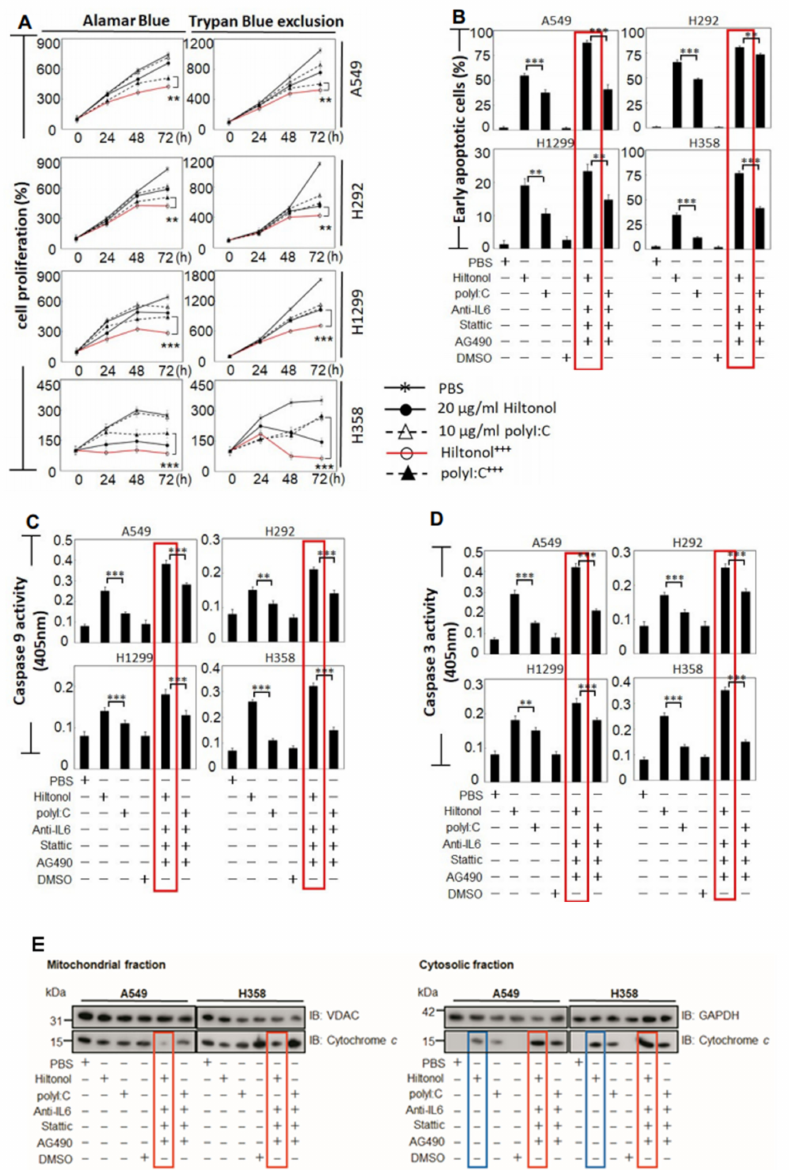
Figure 2. Treatments with Hiltonol +++ dramatically reduced NSCLC (non-small cell lung cancer) cell proliferation and increased early apoptosis of human lung cancer cells. ( A ) The dynamics of cell proliferation were measured using Alamar Blue or Trypan Blue dye exclusion tests. Both Hiltonol and polyI:C significantly decreased cancer cell proliferation. Hiltonol +++ (Hiltonol+anti- IL6+stattic+AG490) further significantly reduced cancer cell proliferation (red line), particularly for H358 cells. The effects of anti-IL6 or Stattic or AG490, or anti-IL6+Stattic+AG490 in NSCLC are shown in Figure 1B and previously in [3]. For each time point, cell counts were normalized with corresponding DMSO vehicle (or PBS) -treated controls. In Alamar Blue assays, the LSD value in A549, H292, H1299, and H358 are 20.486, 24.695, 28.913, and 20.445, respectively. In Trypan Blue exclusion studies, LSD value in A549, H292, H1299, and H358 are 42.633, 26.711, 22.67, and 19.413, respectively. **, p < 0.01; ***, p < 0.001. ( B ) Annexin V and 7-AAD (7-aminoactinomycin) double staining shows significant increase in early apoptosis (Annexin V + /7-AAD − ) when treated with Hiltonol +++ (red boxes). LSD value in A549, H292, H1299, and H358 are 2.918, 2.009, 2.559, and 2.048, respectively. **, p < 0.01; ***, p < 0.001. Representative histograms of apoptosis are shown in Supplementary Figure S1. ( C , D ) Caspases -9 and -3 activities in cells treated with Hiltonol alone